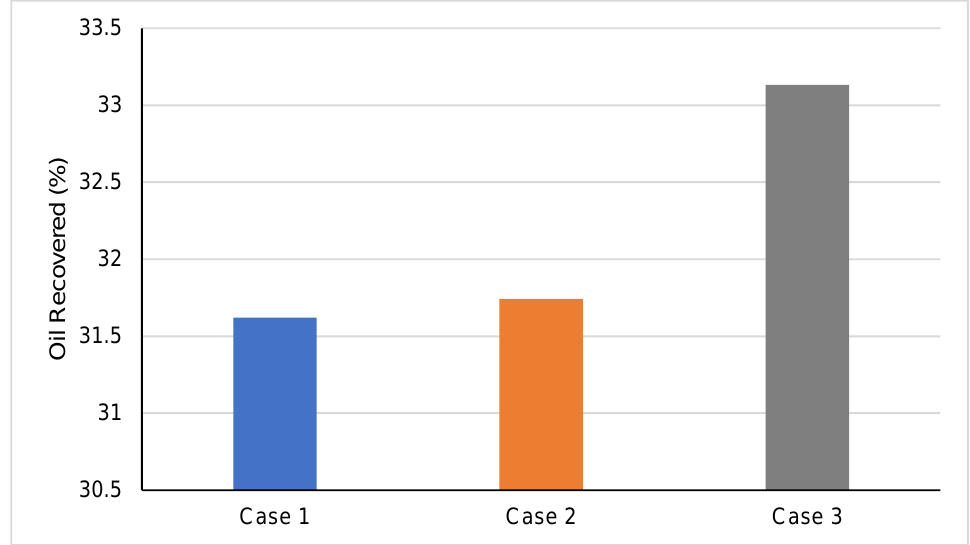
Figure 15. Oil recovered as a percentage of OOIP.